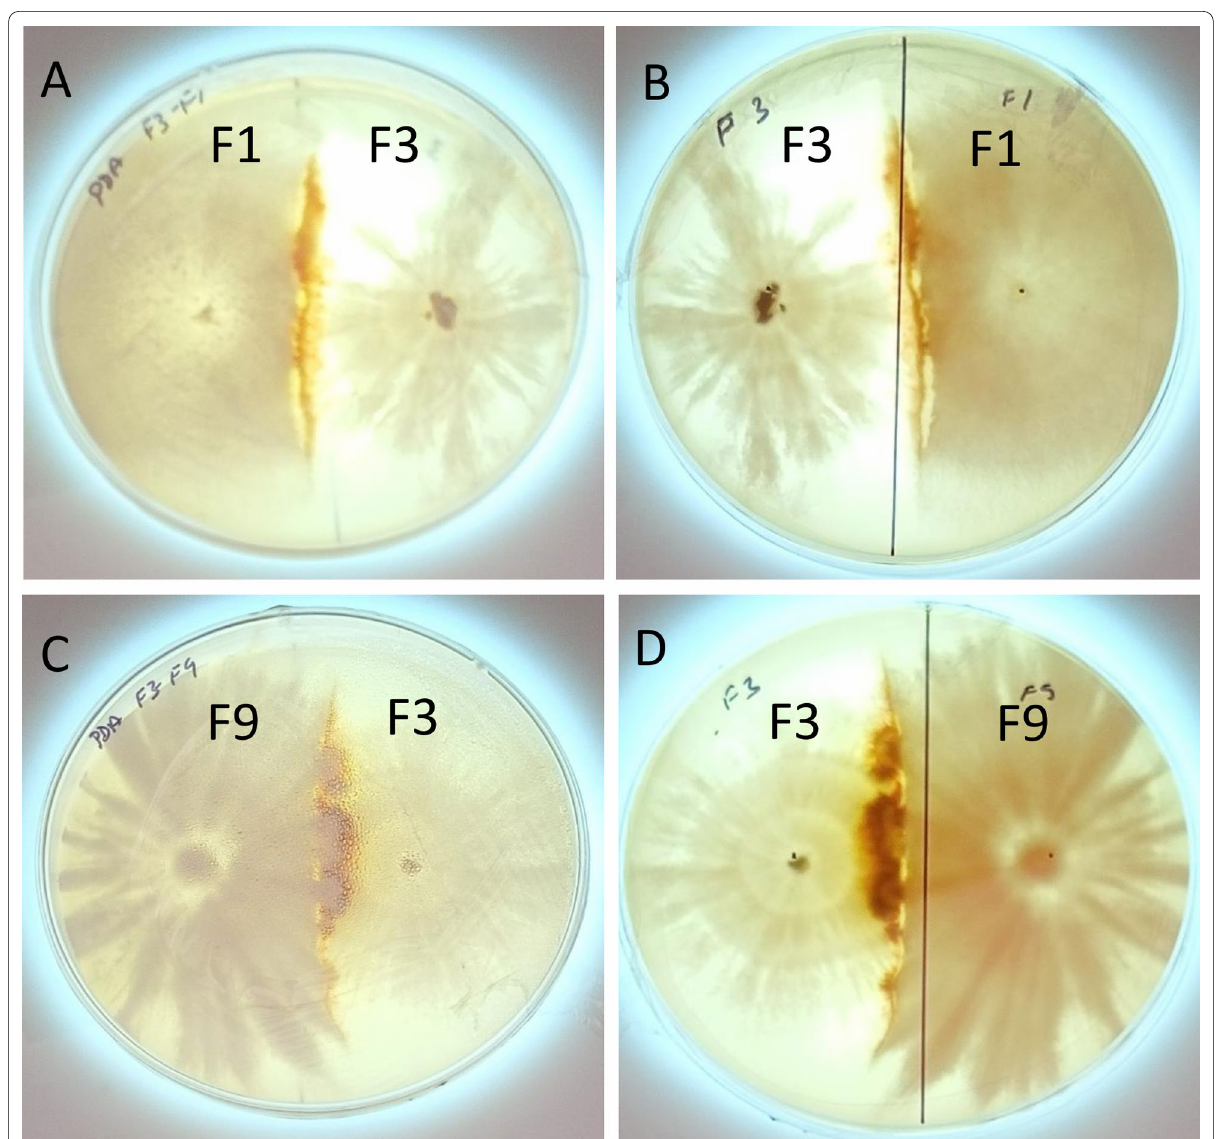
Fig. 1 Interspecific interactions of T. coccinea with T. versicolor and T. coccinea with L. lactinea. A , B Front and back view of the interaction between T. coccinea and T. versicolor. C , D. Front and back view of the interaction between T. coccinea and L.